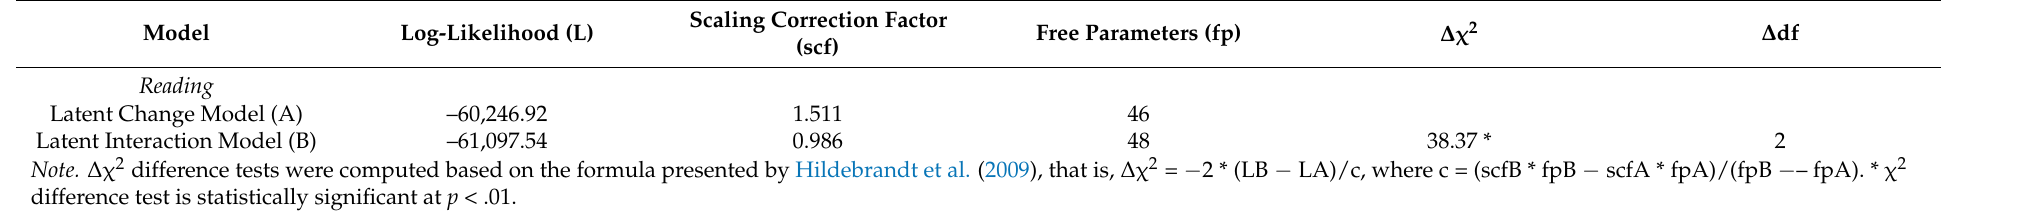
Table 5. Model comparisons of latent interaction models (B) with latent change models without the interaction term (A) in